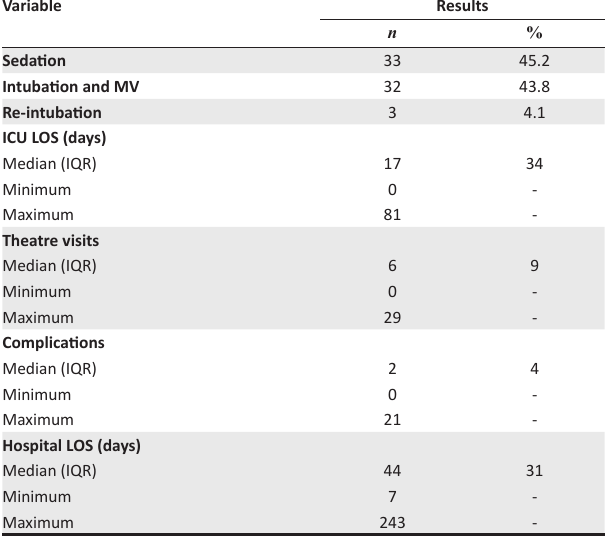
TABLE 3: Clinical course of the cohort during their hospital stay ( n = 73). Variable